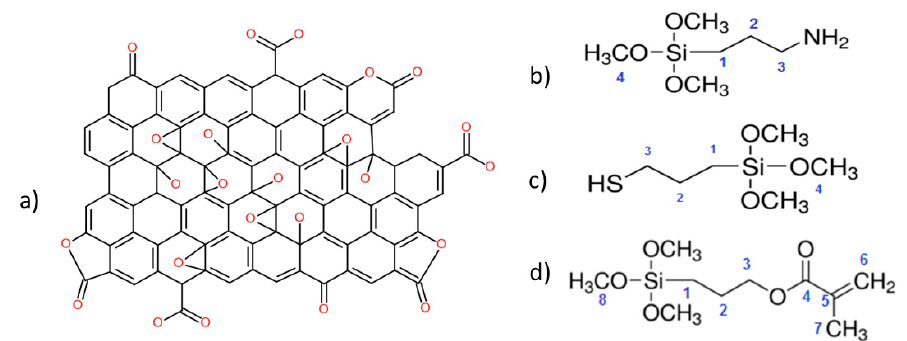
Scheme 1. Molecular structure of ( a ) Graphenea, ( b ) 3-aminopropyltrimethoxysilane (APTMS), ( c ) 3-mercaptopropyltrimethoxysilane (MPTMS), and ( d ) mercaptopropyltrimethoxysilane (MPTMS), and ( d ) 3-methacryloxypropyltrimethoxysilane (MaPTMS). The numbering of carbon atoms used for the peak assignment in the nuclear magnetic resonance (NMR) spectra is also shown.